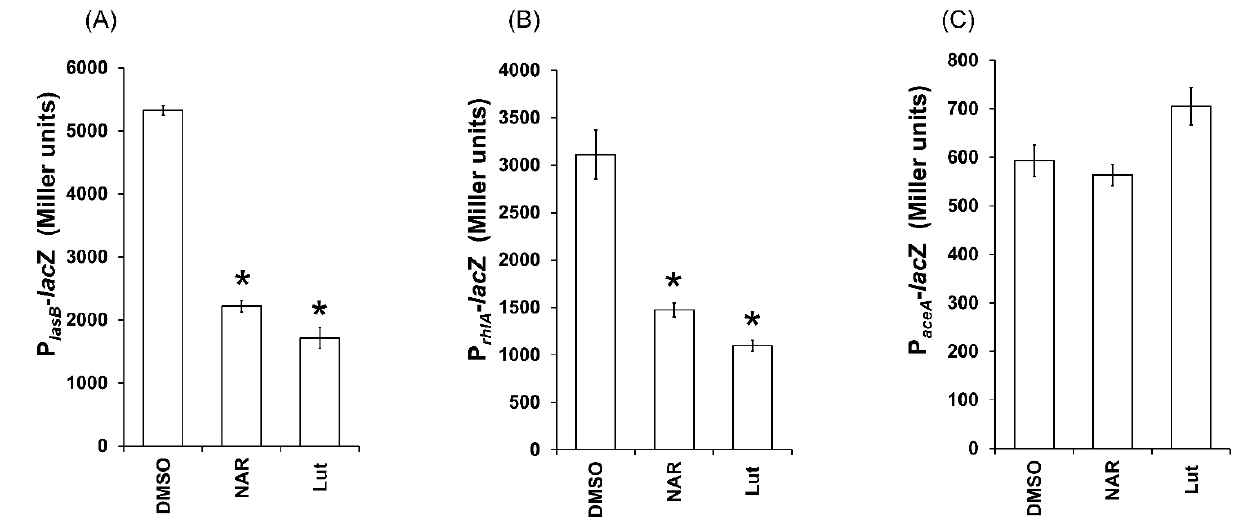
Figure 8. Effect of Lut on the expression of PAO1 QS-regulated lasB and rhlA and the QS-independ- ent aceA after 18 h of incubation. ( A ) Effect of Lut at 22 µM on lasB expression. ( B ) Effect of Lut on rhlA expression. ( C ) Effect of Lut on aceA gene expression. Gene expression was measured as the β - galactosidase activity of the lacZ gene fusions and expressed in Miller units. Naringenin (NAR) was used as a QS inhibitor control and DMSO as a negative control. Error bars represent SEM, and all experiments were performed in quintuplicate with three independent assays; asterisks indicate samples that were significantly different from the DMSO ( p ≤ 0.01).